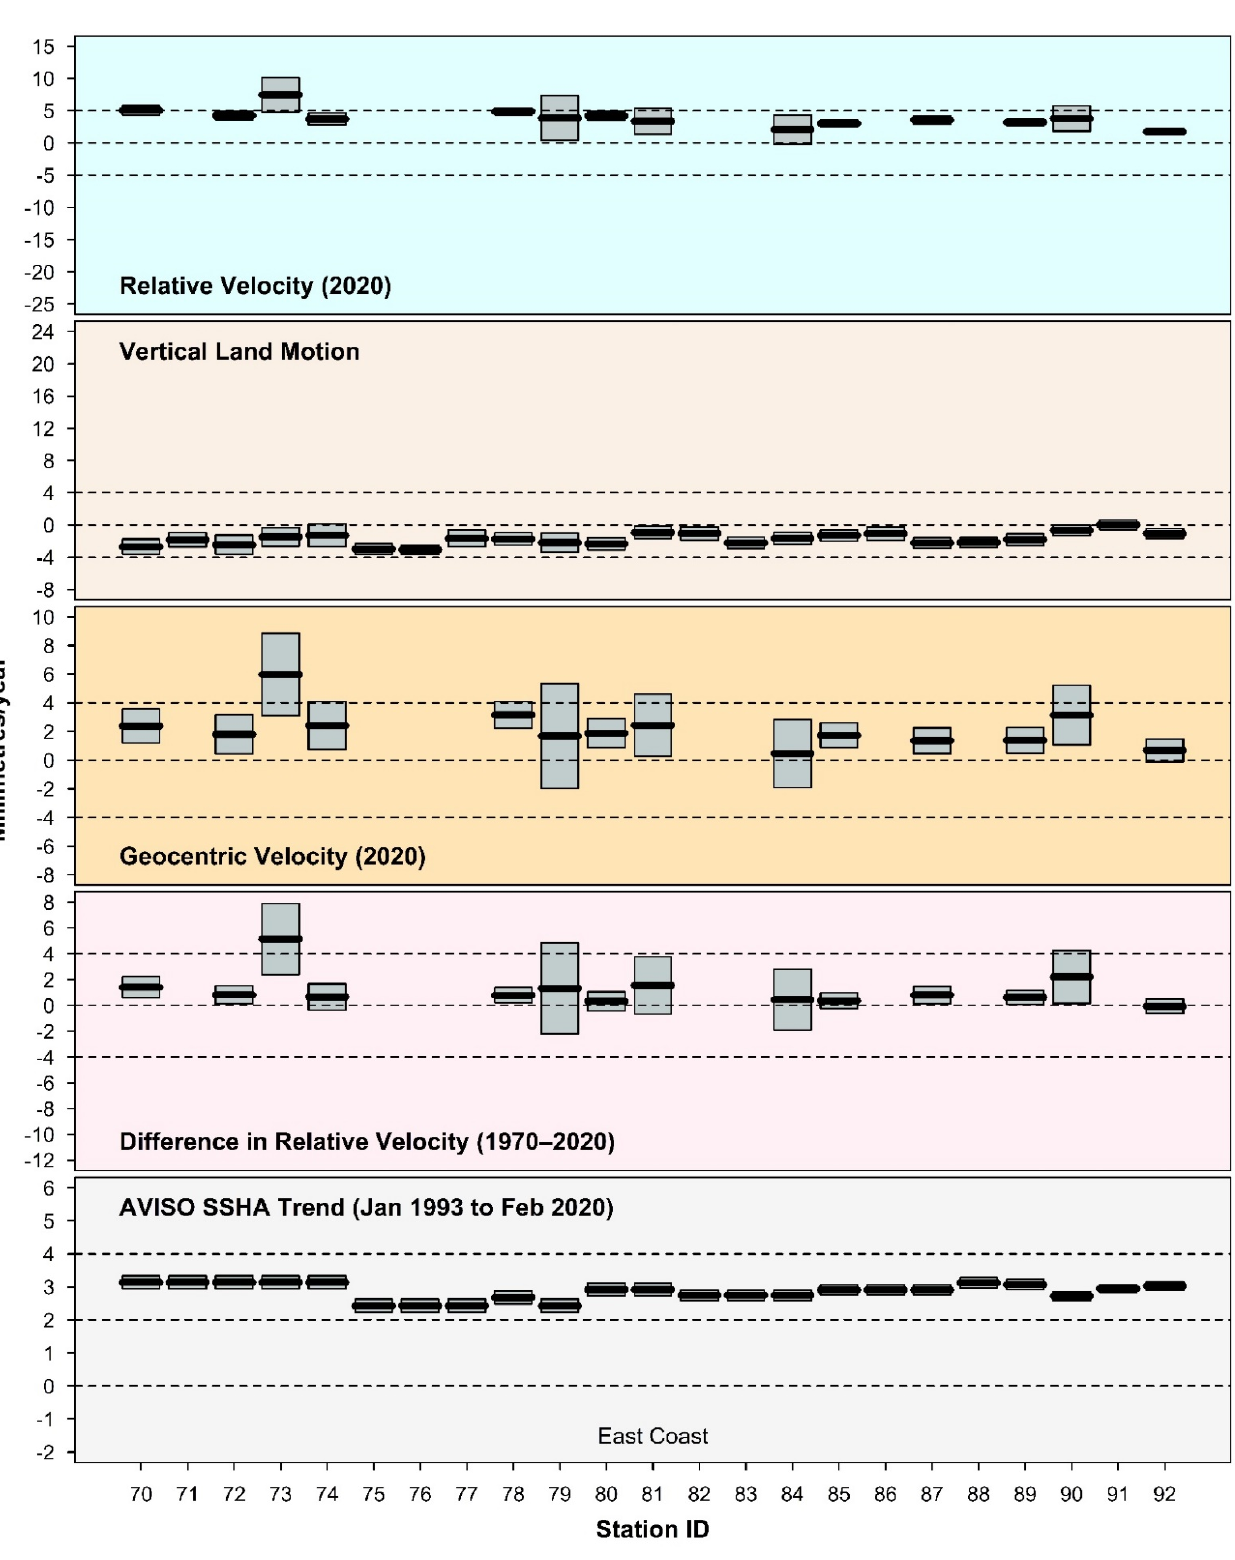
Figure 5. Summary of results for Station ID’s 70–92. Refer to Figure 1 and Table 1 for station ID details. Shaded boxes represent 95% CL for each set of results. Vertical lines demarcate respective sectors of coast which are denoted in the bottom panel. For details on the methodology underpinning the respective charts, refer Section 2.